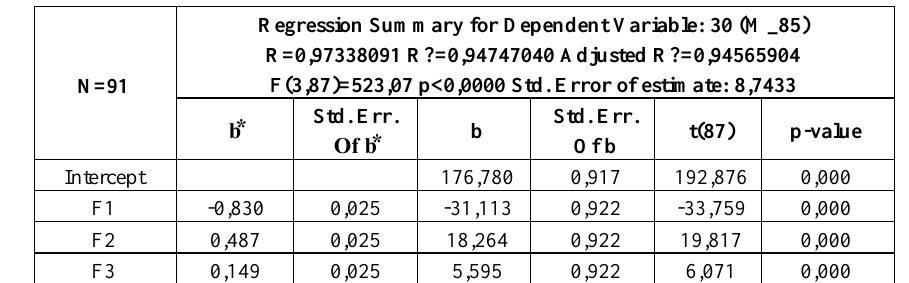
Table 3. - Regression parameters of passenger flows restoration at SP